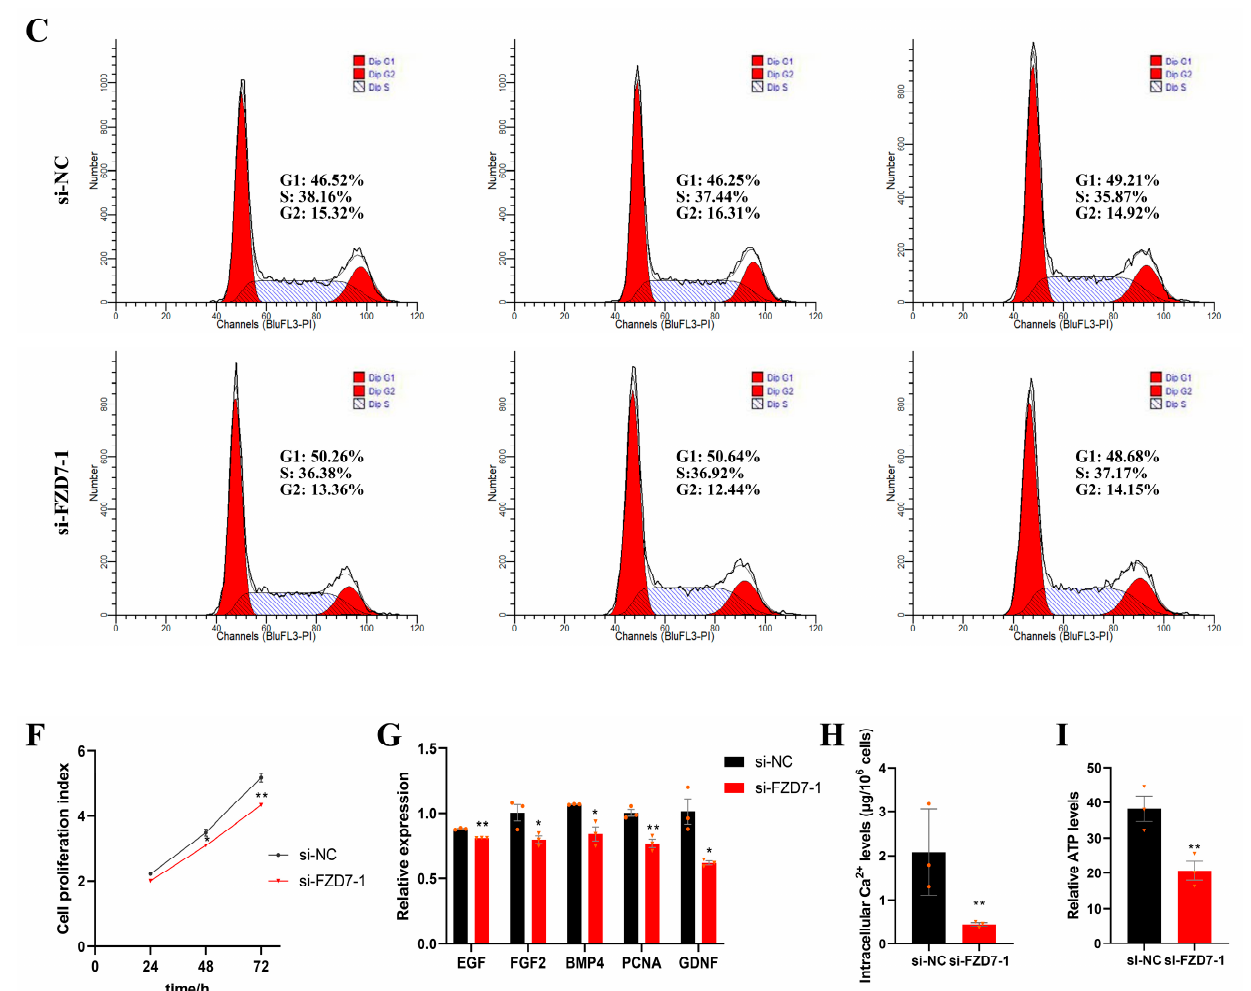
Figure 5. FZD7 promotes the proliferation of immature porcine Sertoli cells. ( A ) The location of FZD7 in porcine testicular tissue. Testicular tissues of newborn pigs were used in this experiment. FZD7 is marked in red and SOX9 is marked in green. ( B ) Sertoli cells were treated with RNAi for FZD7 (si- FZD7 -1, -2, and -3). The inhibition efficacy was evaluated using the qPCR assay. si-NC—negative control of RNAi. ( C ) The CCK-8 assay was used to measure the cell proliferation index. ( D ) Relative mRNA expression of the key genes of cell proliferation. ( E , F ) show the cell cycle was analyzed using a FACSCanto II flow cytometer, and the G1, S, and G2 phases of the cell cycle were counted in cells transfected with si- FZD7 -1. ( G ) Relative mRNA expression of the key genes of cell cycles. ( H ) Intracellular Ca 2+ levels were measured using ICP-MS. ( I ) The relative ATP level was measured using an ATP assay kit. Orange triangles and circles represented the numerical distribution of three biological repeats in each group. Data were presented as the mean ± SEM. * p < 0.05, ** p < 0.01 and *** p <